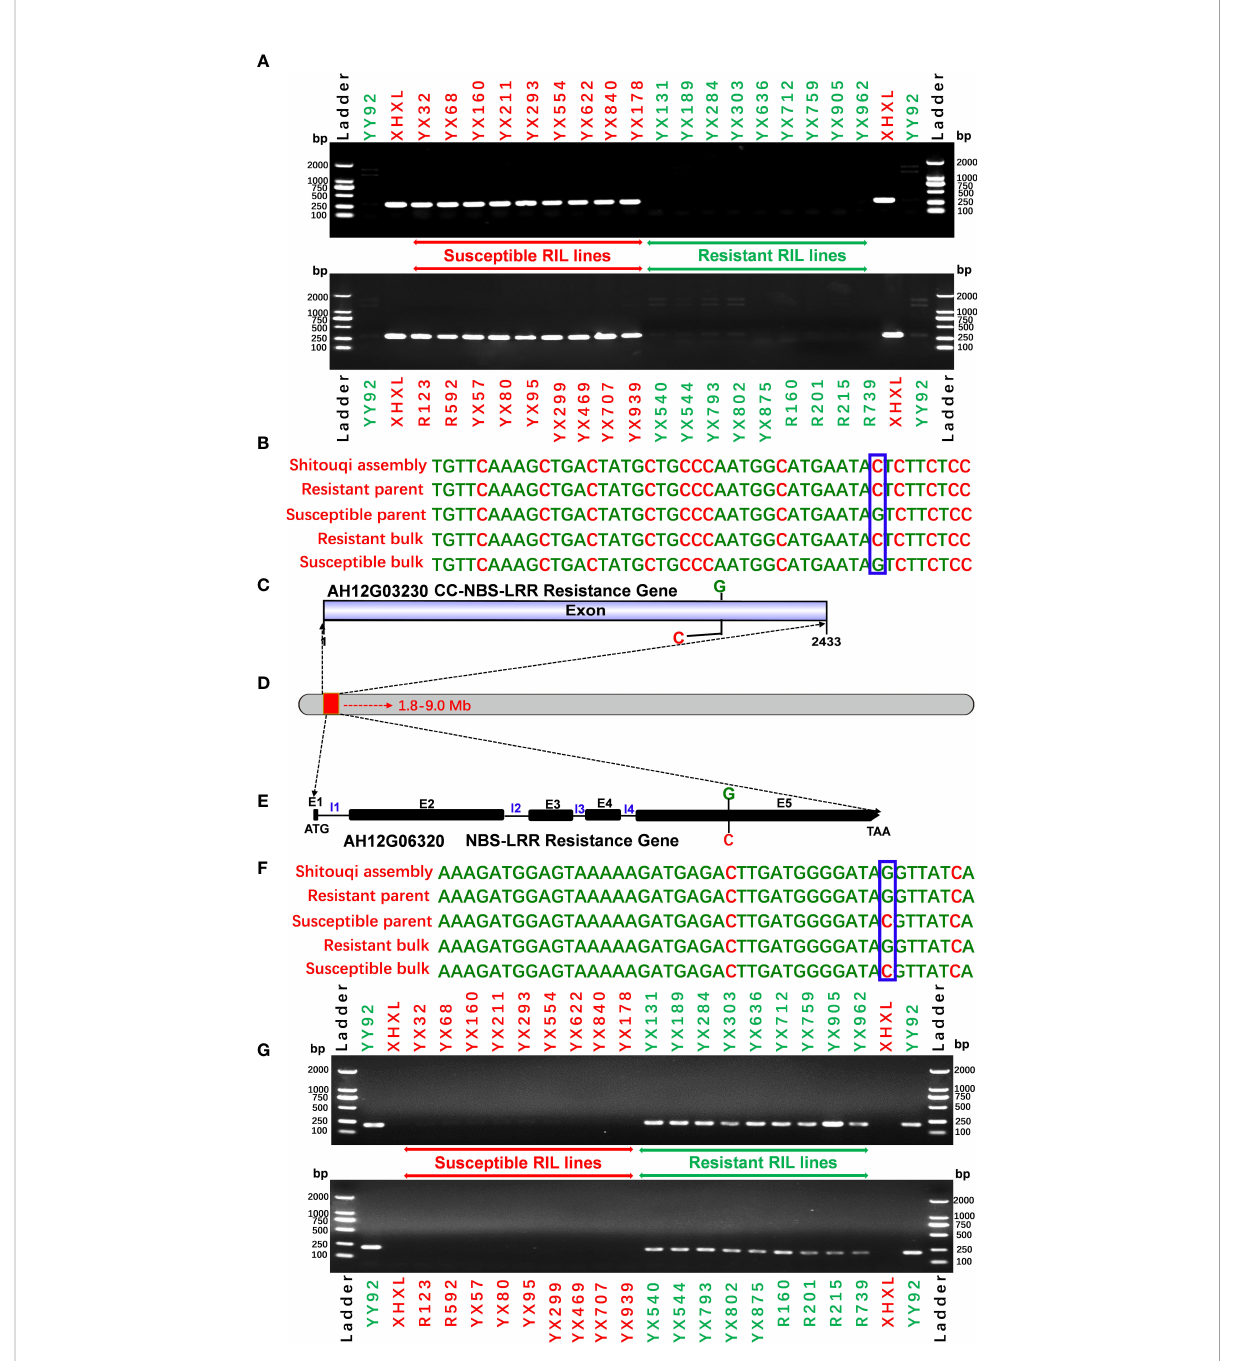
FIGURE 5 Validation of putative candidate gene-based markers of bacterial wilt resistance. (A) The SNP marker validation of candidate gene AH12G03230 using a validation set comprising the resistant parent YY92, susceptible parent XHXL, and susceptible and resistant RIL lines). (B) SNP variation in the AH12G03230 gene. (C) The AH12G03230 gene is predicted to encode the CC-NBS-LRR resistance protein. (D) Putative genomic region on Chromosome 12 of Arachis hypogaea that encodes resistance to Ralstonia solanacearum infections (E) The AH12G06320 gene is predicted to encode the NBS-LRR resistant protein (E1 to E5 refer to exon numbers while I1 to I4 refer to intron numbers), (F) SNP variation in the AH12G06000 gene and (G) marker validation on a validation set comprising resistant parent YY92, susceptible parent XHXL, susceptible RIL lines (YX32, YX68, YX160, YX211, YX293, YX554, YX622, YX840 and YX178, R123, R592, YX57, YX80, YX95, YX299, YX469, YX707 andYX939), and resistant RIL lines (YX131, YX189, YX284, YX303, YX636, YX712, YX759, YX905, YX962, YX540, YX544, YX793, YX802, YX875, R160, R201, R215 and